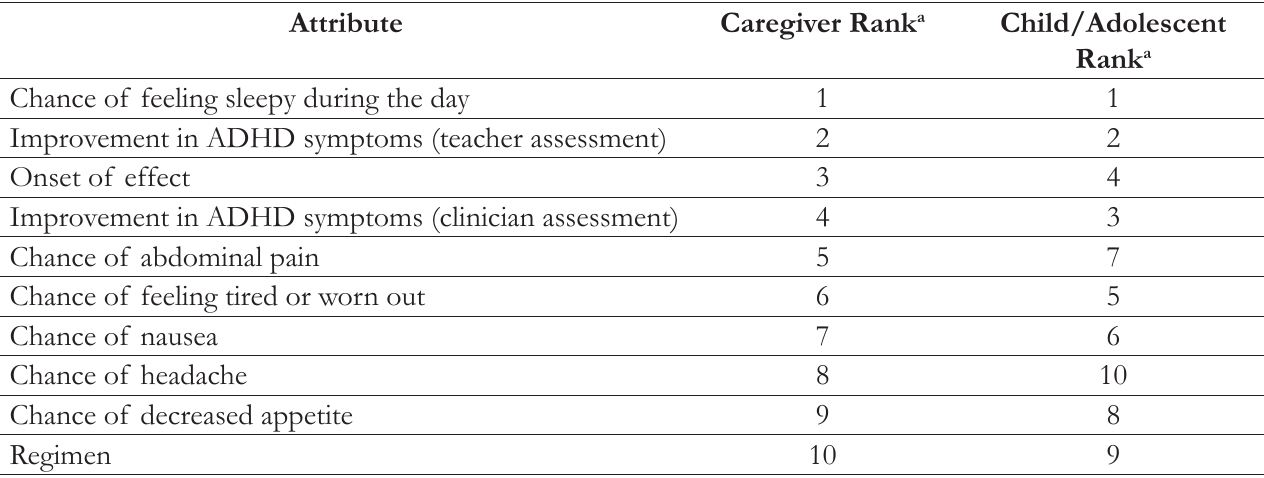
Table 4. Comparing Rank Order of Importance among Attributes Common to both Caregiver and Child/ Adolescent